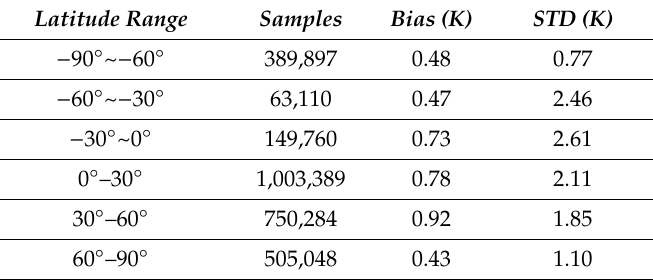
Table 9. The LST di ff erence over latitude Table 9. The LST difference over latitude distribution.